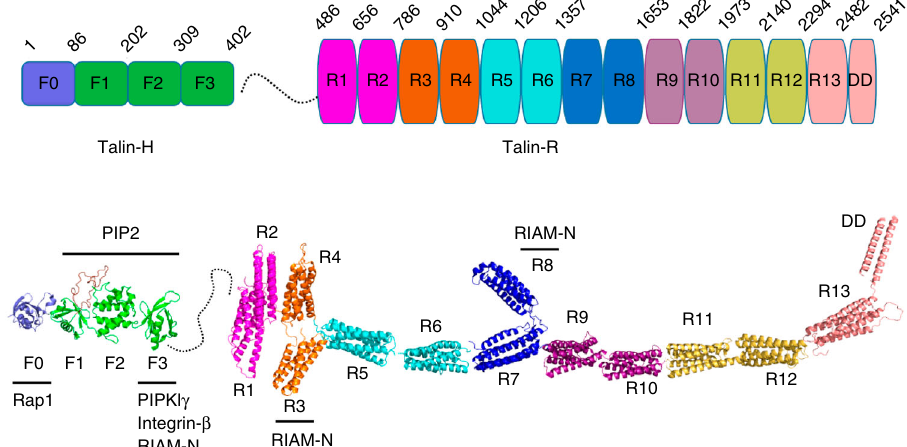
Fig. 1 Domain organization and a linear structural model of talin. The model was generated from known crystal and NMR structures of talin fragments and shown in cartoon representation. Critical talin-binding partners involved in talin membrane recruitment and activation are indicated in the fi gure. PIP2 phosphatidylinositol-4,5-bisphosphate, RIAM-N the N terminus of RIAM, PIPKI γ type I phosphatidylinositol phosphate kinase isoform-